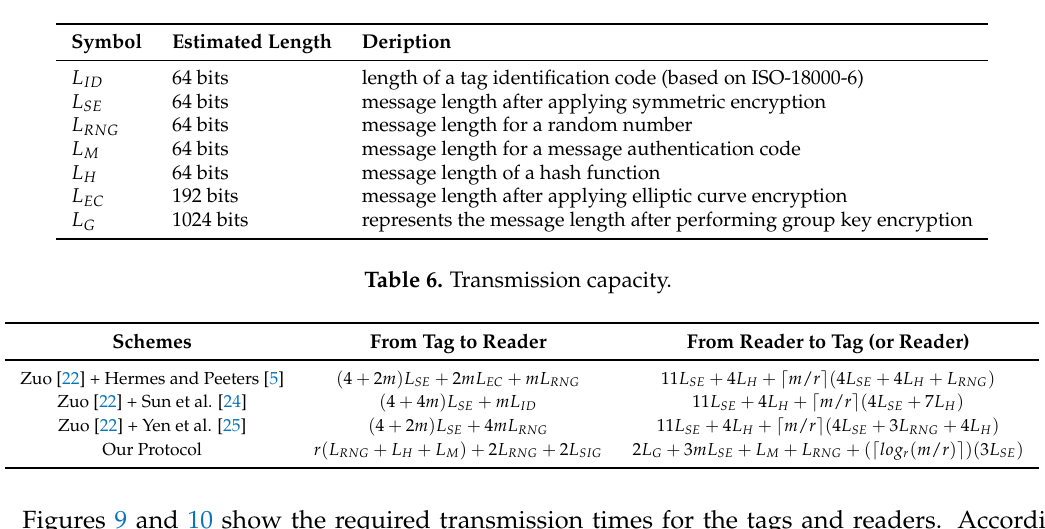
Table 5. Transmission capacity, symbol notation, and estimated length.